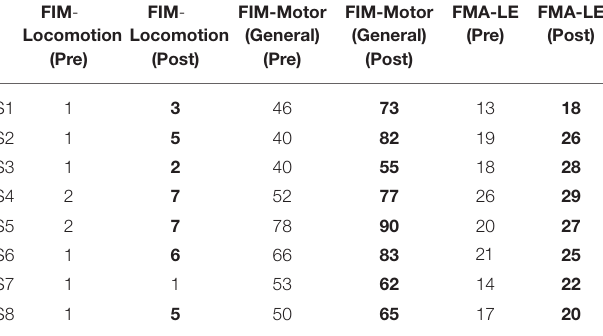
TABLE 2 | Clinical Measures Pre-Post robotic intervention.